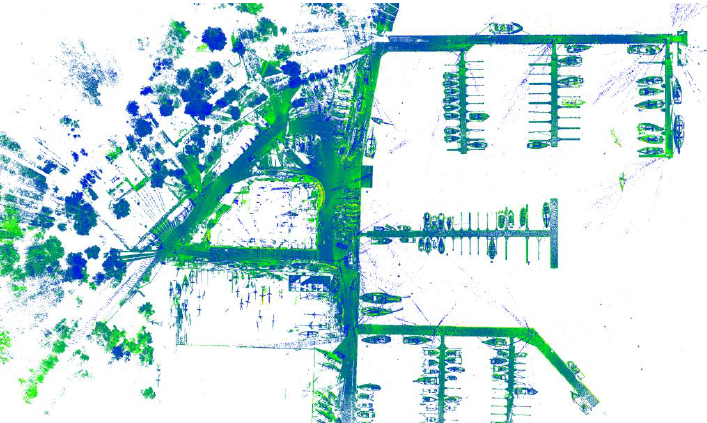
Figure 8. 2D imaging of the point cloud resulting from laser scanning of the NSC yacht port.